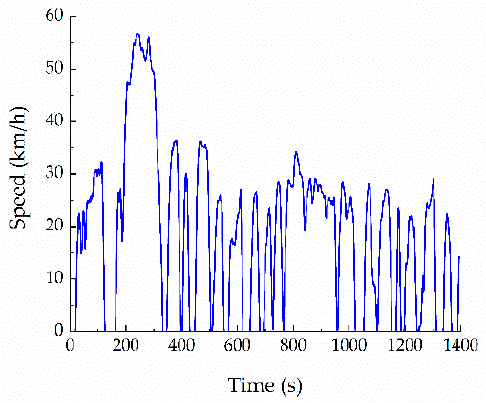
Figure 6. UDDS speed condition diagram.